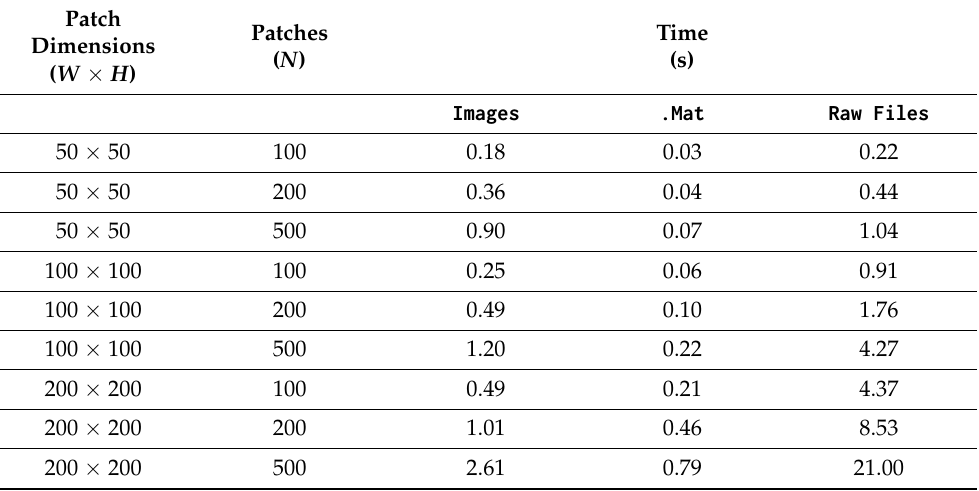
Figure 9. Illustration of the first 20 randomly generated patches on a selected map (2000 px resolution; map scale level, 1:10 k). The patches shown have dimensions 100 × 100 and are randomly positioned all over the map image, and full overlapping of patches is allowed. Table 7. Average time requirements regarding the patch creation process for various combinations of patch number and size. All three output options are considered, namely saving the patches to image files, to a MATLAB .mat file, and to raw text